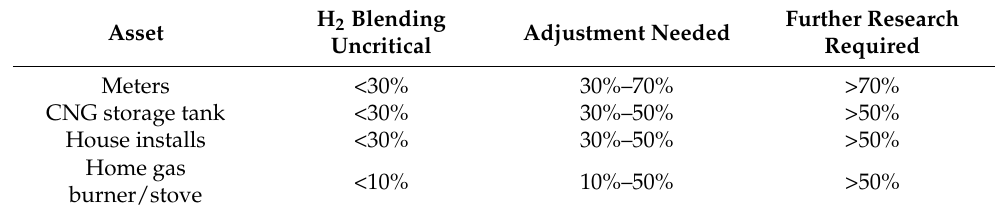
Table 4. Sensitivity of selected natural gas infrastructure assets to hydrogen admixture as reported in [64].